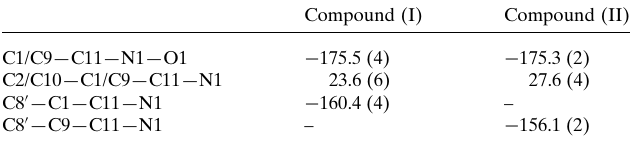
Table 3 Hydrogen-bond geometry (A˚ , (cid:2) ) for (II).